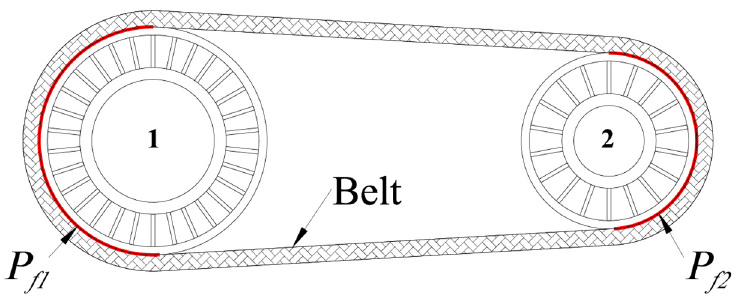
Figure 2. Two-pulley, one-belt system.